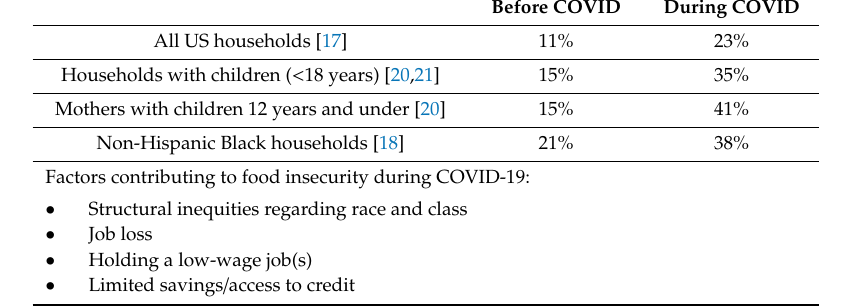
Table 1. Food insecurity rates before and during COVID-19 for select population groups. Population Group Before COVID During